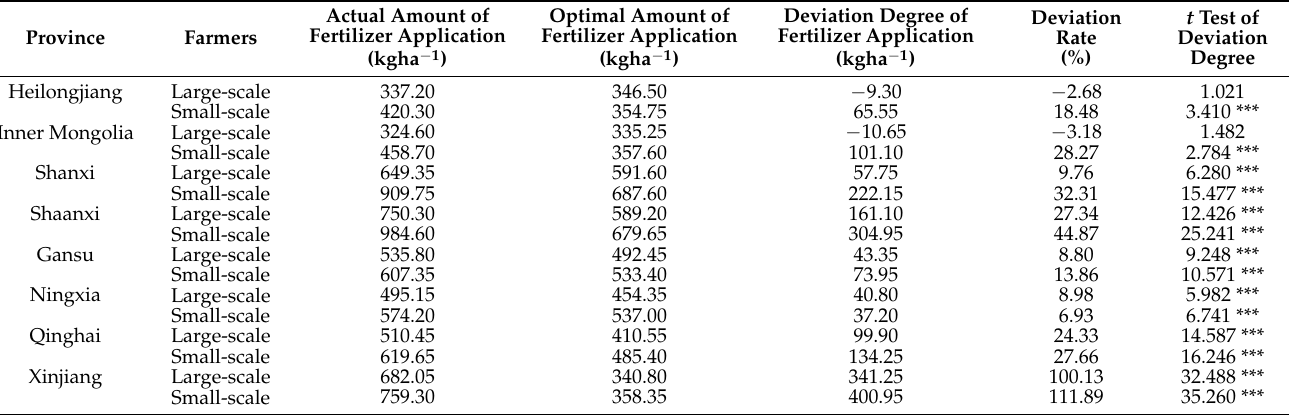
Table 6. Deviation of fertilizer use between large-scale and small-scale farmers in different provinces. Province